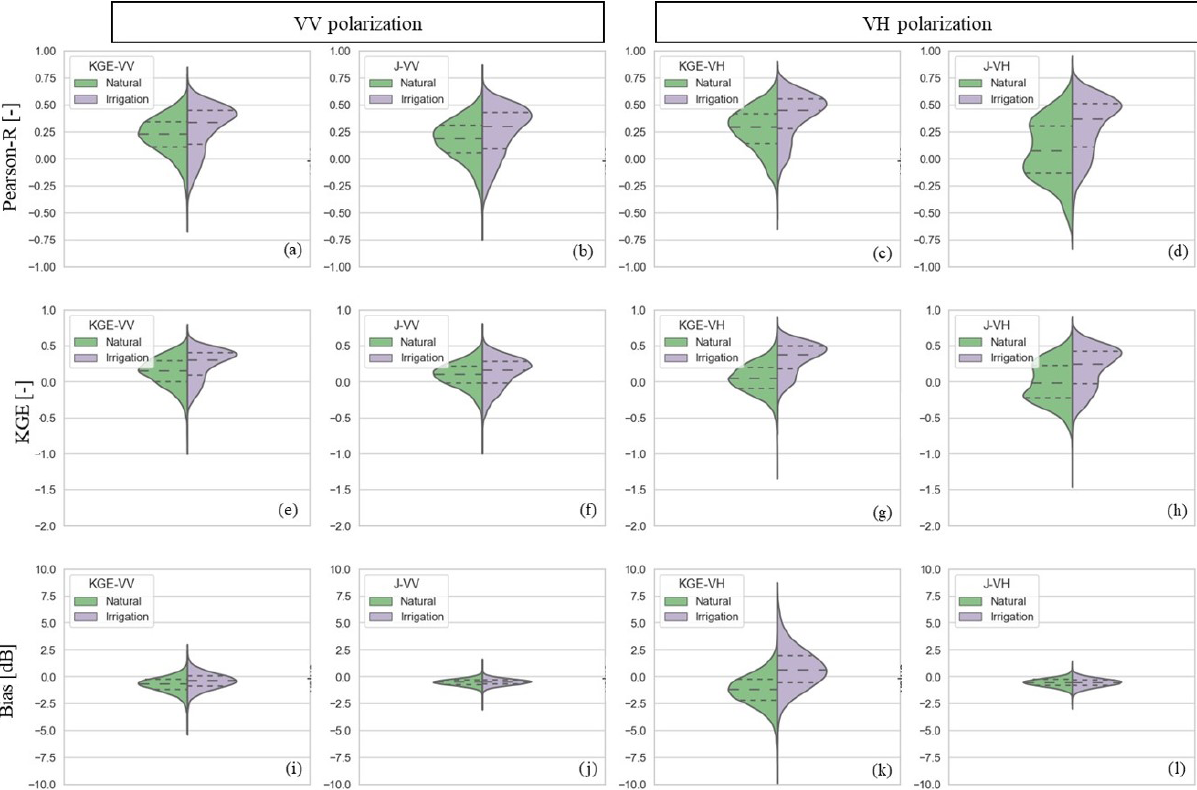
Figure 10. Split violin distributions of (a–d) Pearson R , (e–h) KGE, and (i–l) bias calculated between σ 0 simulations and observations for the validation period, for all the calibration experiments and considering only the cropland areas, using simulations from the natural run (left; green) and the irrigation run (right; violet). The results are shown for VV (first two columns) and VH (right two columns) and alternate for both the calibration with a J and KGE cost function. Note that the areas under the histograms on both left and right sides of the violins are automatically scaled for optimizing the